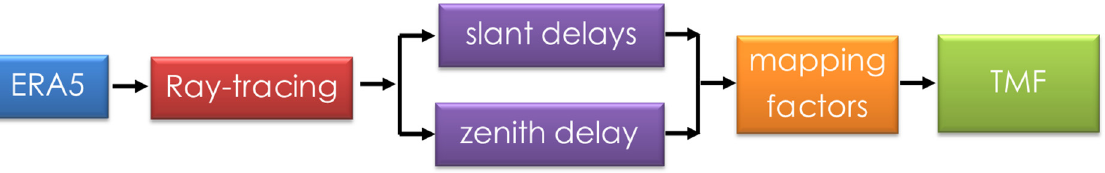
Figure 1. Procedure for determination of TMF.